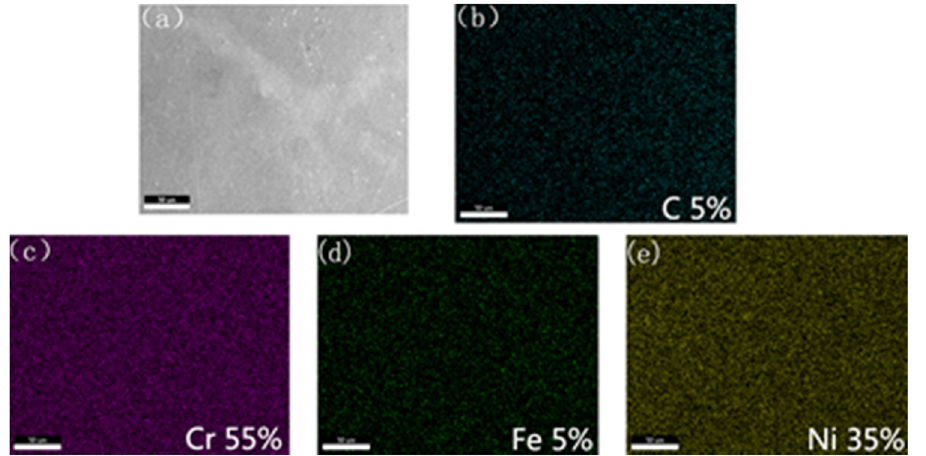
Figure 1: EDS sweep spectrum of wrench surface. ( a ) SEM image of wrench surface, ( b ) C 5%, ( c ) Cr 55%, ( d ) Fe 5%, and ( e ) Ni 35%.